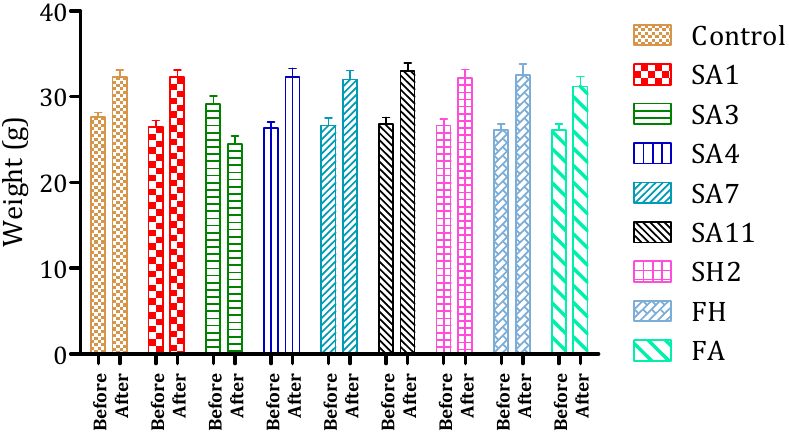
Figure 10. Toxicity evaluation by weight comparison of mice before and after administration of the hexane (EH) and acetone (EA) mother extracts and their fractions.